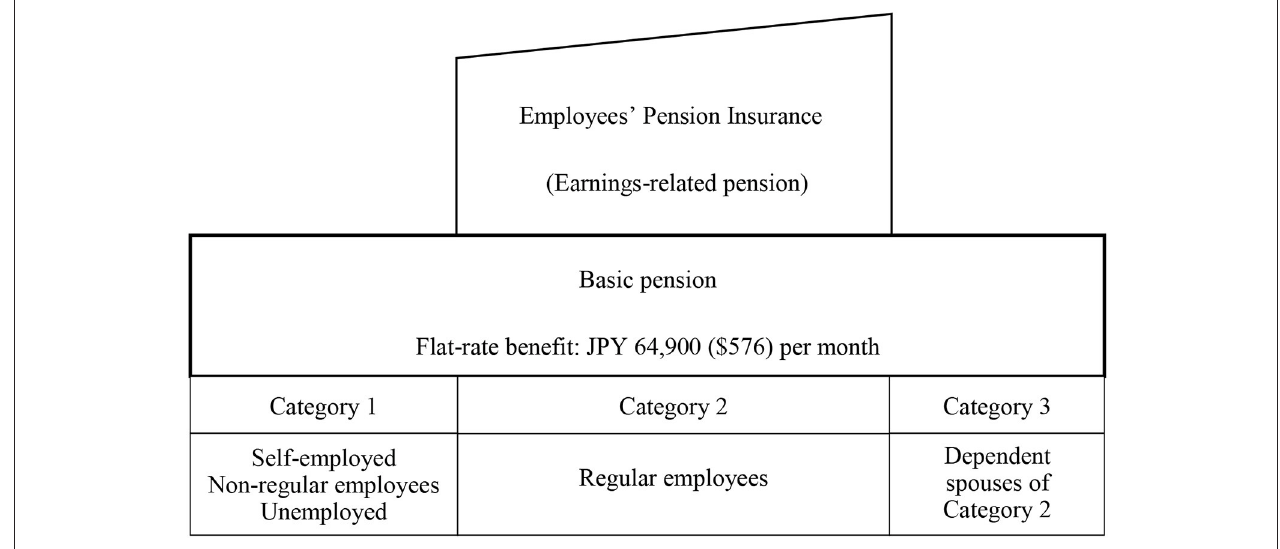
FIGURE 1 | Public pension scheme in Japan. Source: Inagaki [2]. The amount of pension benefit is recalculated pursuant to the National Pension Act.